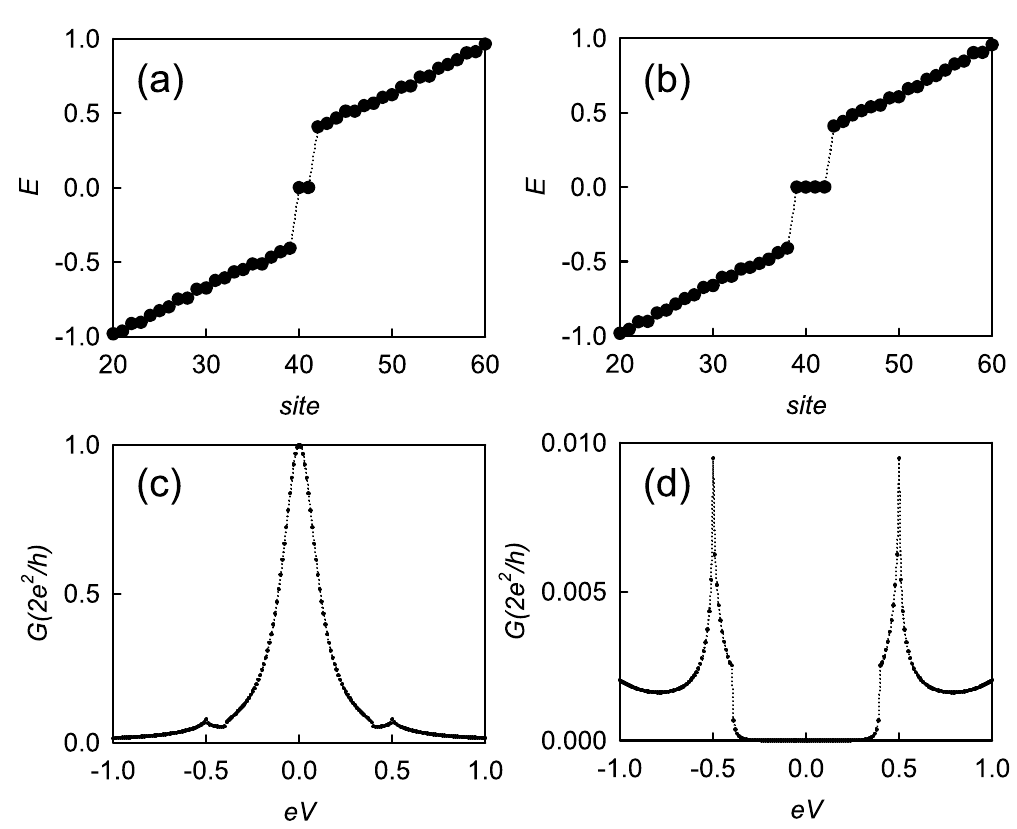
Figure 3. The open energy spectrum for the case of two Majorana chains: ( a ) ′ = − . ′ = − . t t 0 8, 0 4 with the 1 2 winding number N = 1, N ′ = 1; ( b ) ′ = − . ′ = − . t t 0 4, 0 8 with the winding number N = 0, N ′ = 2. ( c , d ) the 1 2 conductance of a normal lead/topological superconductor junction as a function of voltage with the topological superconductors described in ( a , b ), respectively. In ( c ), the width of the peak is controlled by the transparency of the junction, i.e., the hopping t c between the normal and superconducting sides of the junction. The width increases as t c is decreased, which is similar to the case of unconventional superconductor 33 . The other parameters are t 1 = 0.5, t 2 =